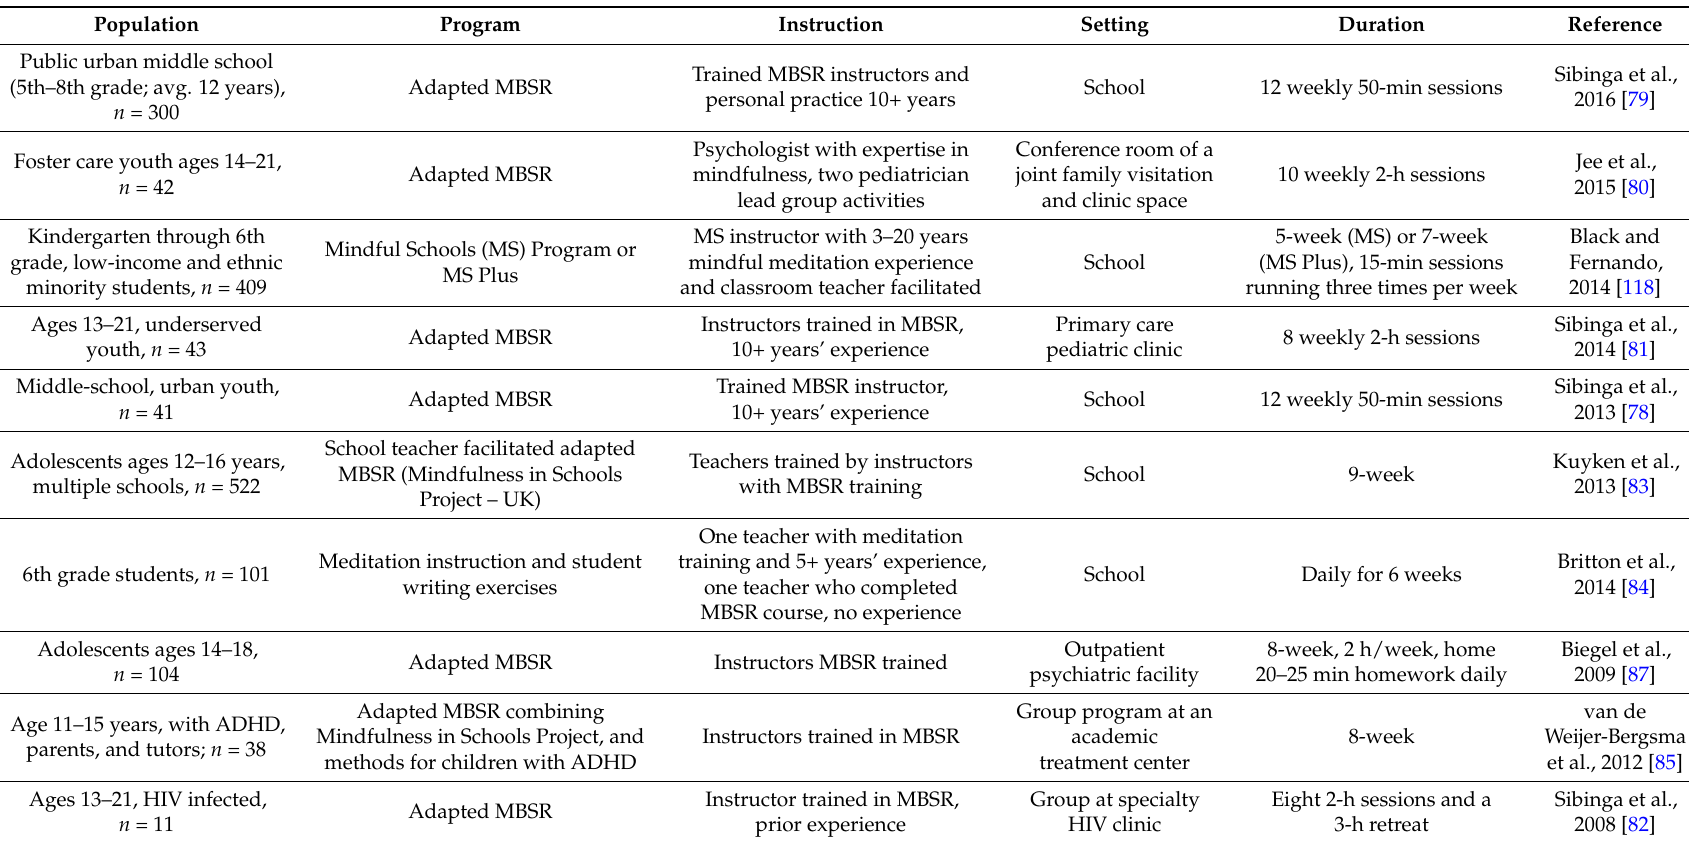
Table 2. Variations in mindfulness programs and